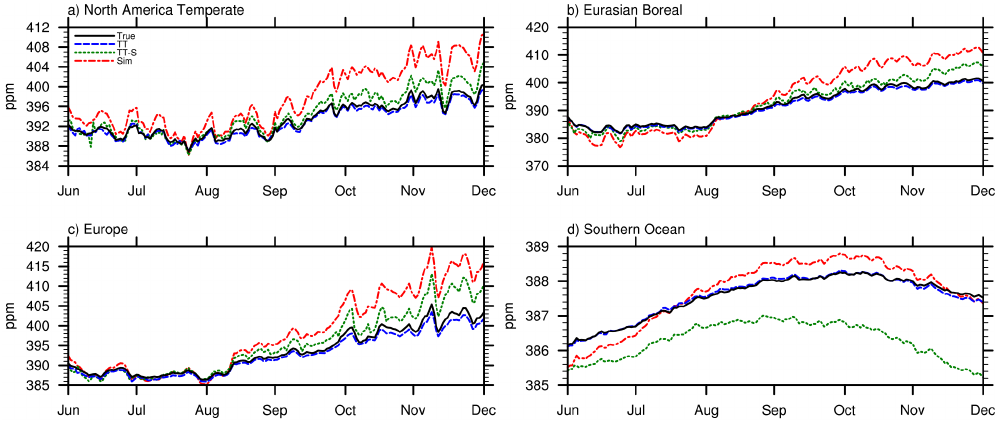
Figure 9. Same as Fig. 8 but for CO 2